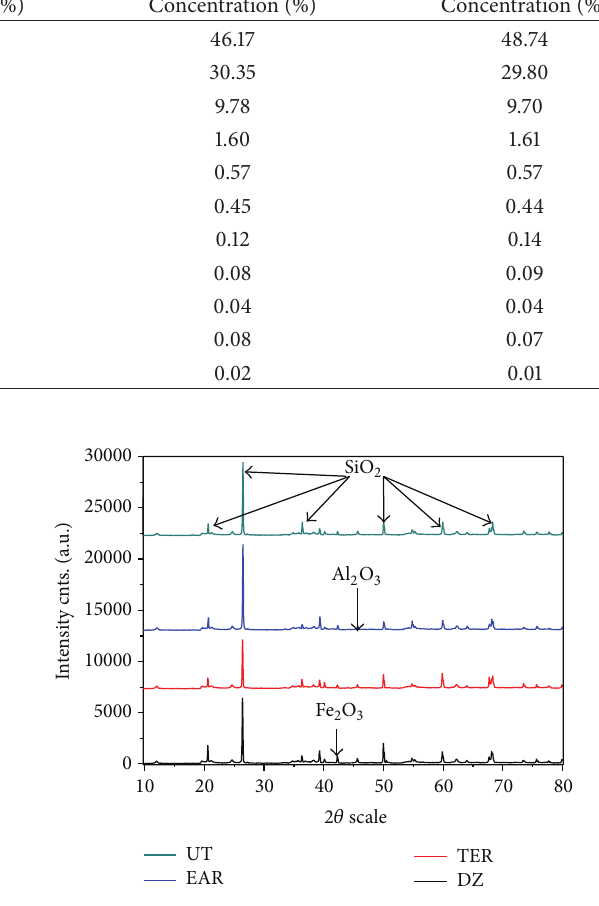
Figure 7: Comparison of XRD results for untreated (UT) soil samples and soils treated with three